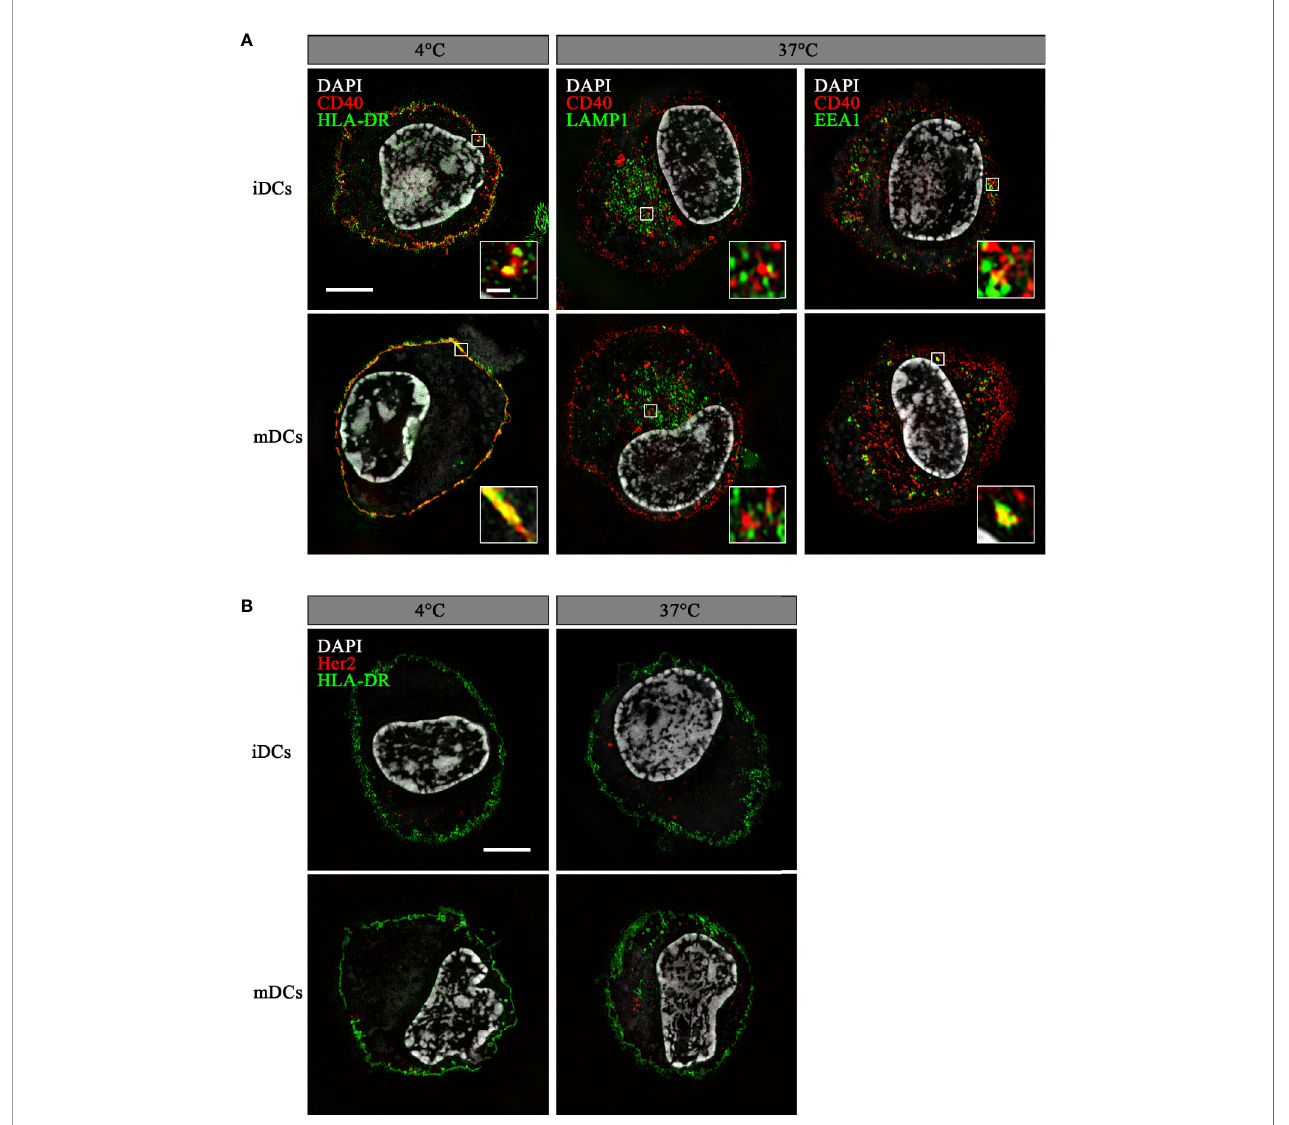
FIGURE 2 | a CD40 CMV internalized into early endosomal compartments upon binding to CD40. Internalization of a CD40 CMV -AF594 (A) or of the non-speci fi c binding control a Her2 CMV -AF594 (B) into iDCs and mDCs after incubation for 1.5 h at 4°C and 37°C. Co-staining with a HLA-DR-AF488 (membrane) was performed at 4°C and with a Her2 CMV at 37°C. a CD40 CMV -treated DCs were stained with a LAMP1-AF488 (late endosomes) and a EEA1-AF488 (early endosomes) at 37°C. Internalization was visualized by structured illumination microscopy. Fluorescent signal within enlarged images is enhanced until saturation of the endosomal signals to better visualize co-localization. The scale bar represents 5 µm and in the enlarged images 0.5